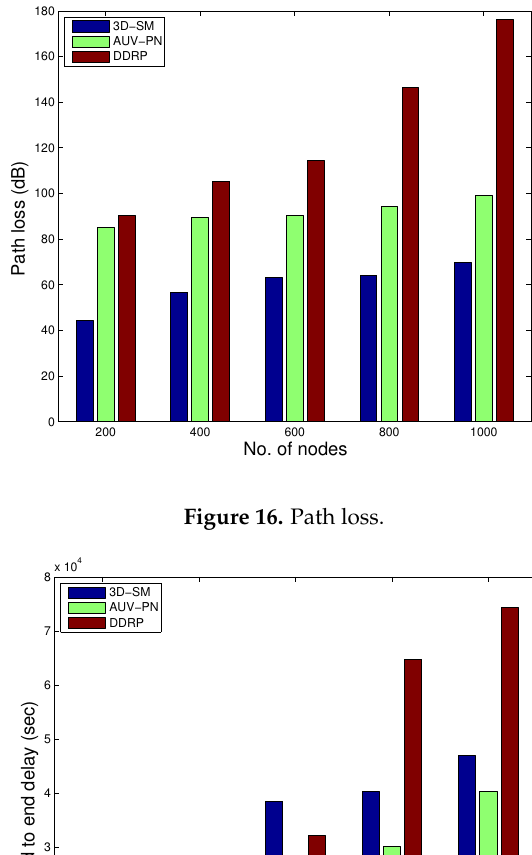
Figure 16. Path loss.